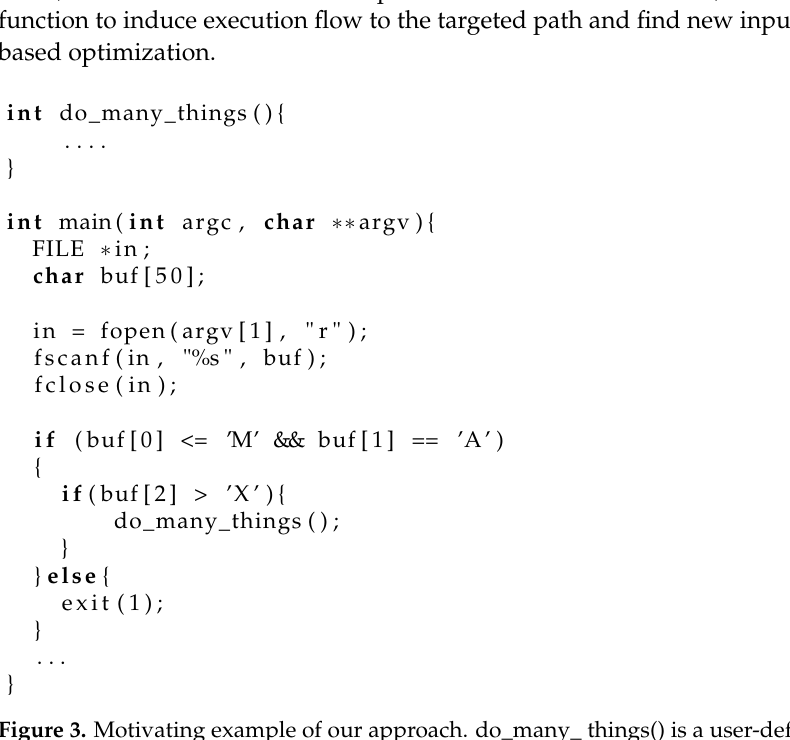
Figure 3. Motivating example of our approach. do_many_ things() is a user-defined function with large source code.